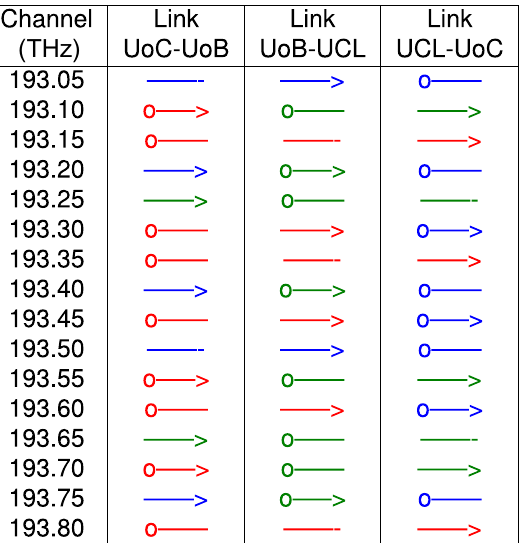
Table 6. Routeing and channel assignment for virtual ring performance verification. Signals propagate from “o—” left to right and loop round to “—>”. Colours designate signal origin.